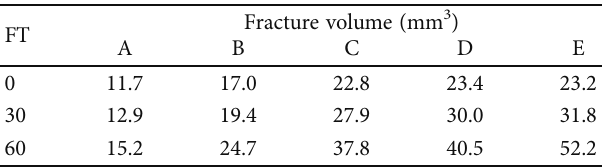
Figure 6: Fracture evolution process of fi ve sandstone samples with di ff erent saturation. Table 2: The fracture volume values of fi ve sandstone samples with di ff erent saturation.